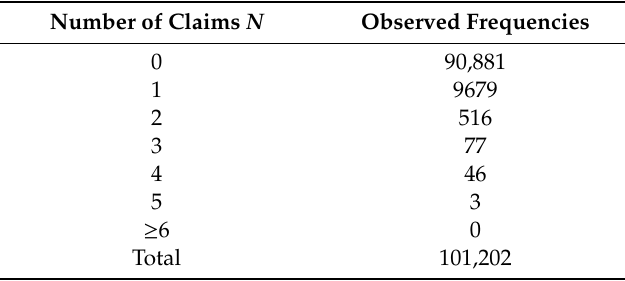
Table 2. Claim frequencies of policyholders in the